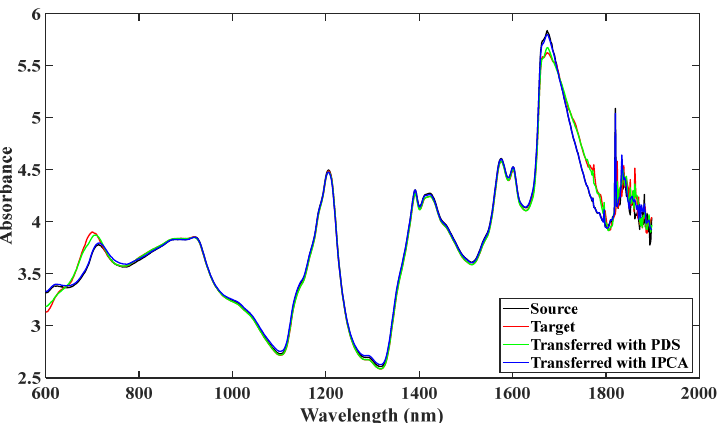
Figure 3. Raw and transferred spectrum of arbitrarily selected sample in dataset 1. Source, target, and spectrum transferred by PDS and IPCA represented by black, red, green, and blue curve, re- spectively.